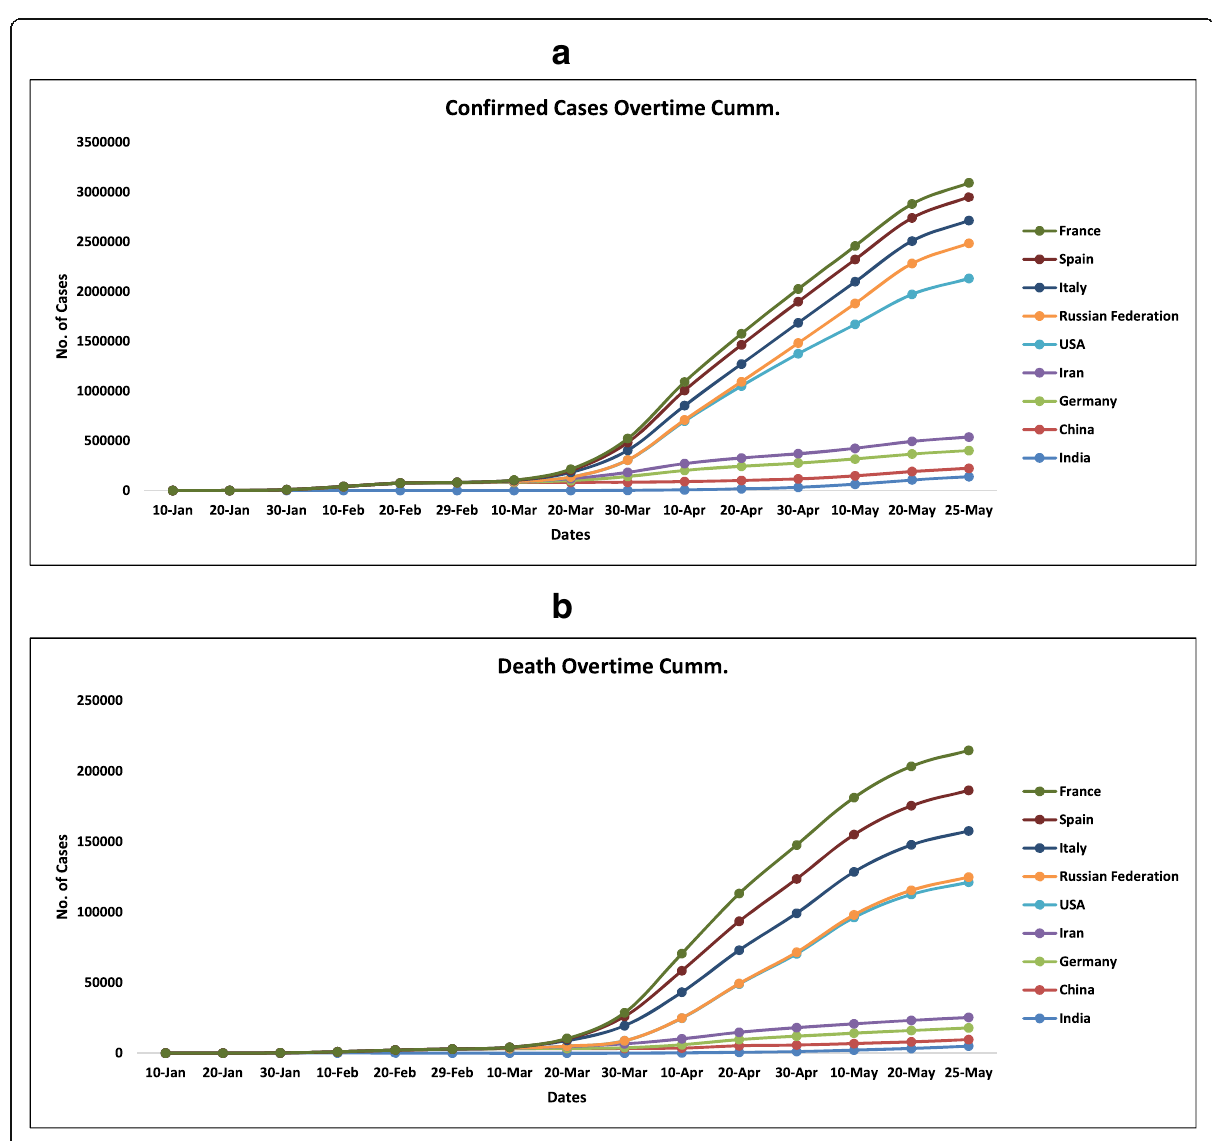
Fig. 4 a Graph of confirmed (cumulative) cases overtime in various countries . b Graph of death (cumulative) overtime in various